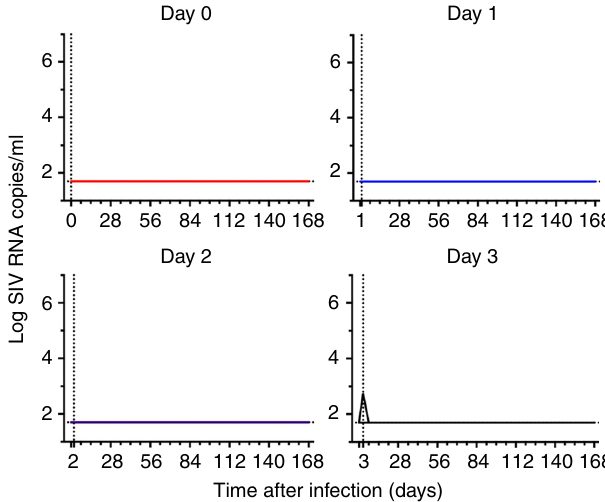
Fig. 1 Plasma viral kinetics in SIV-infected rhesus monkeys following initiation of ART on days 0, 1, 2 and 3 post infection. Log plasma SIV RNA was monitored in rhesus monkeys following initiation of ART (N = 5/ group) on day 0 (6 h), day 1, day 2, and day 3 following intrarectal SIVmac251 infection. Assay limit of detection (<50 RNA copies/ml) and day of ART initiation are indicated with hatched